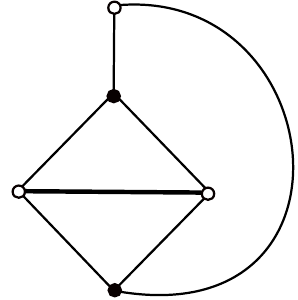
Figure 3. The graph H by adding one edge to the graph K 2,3